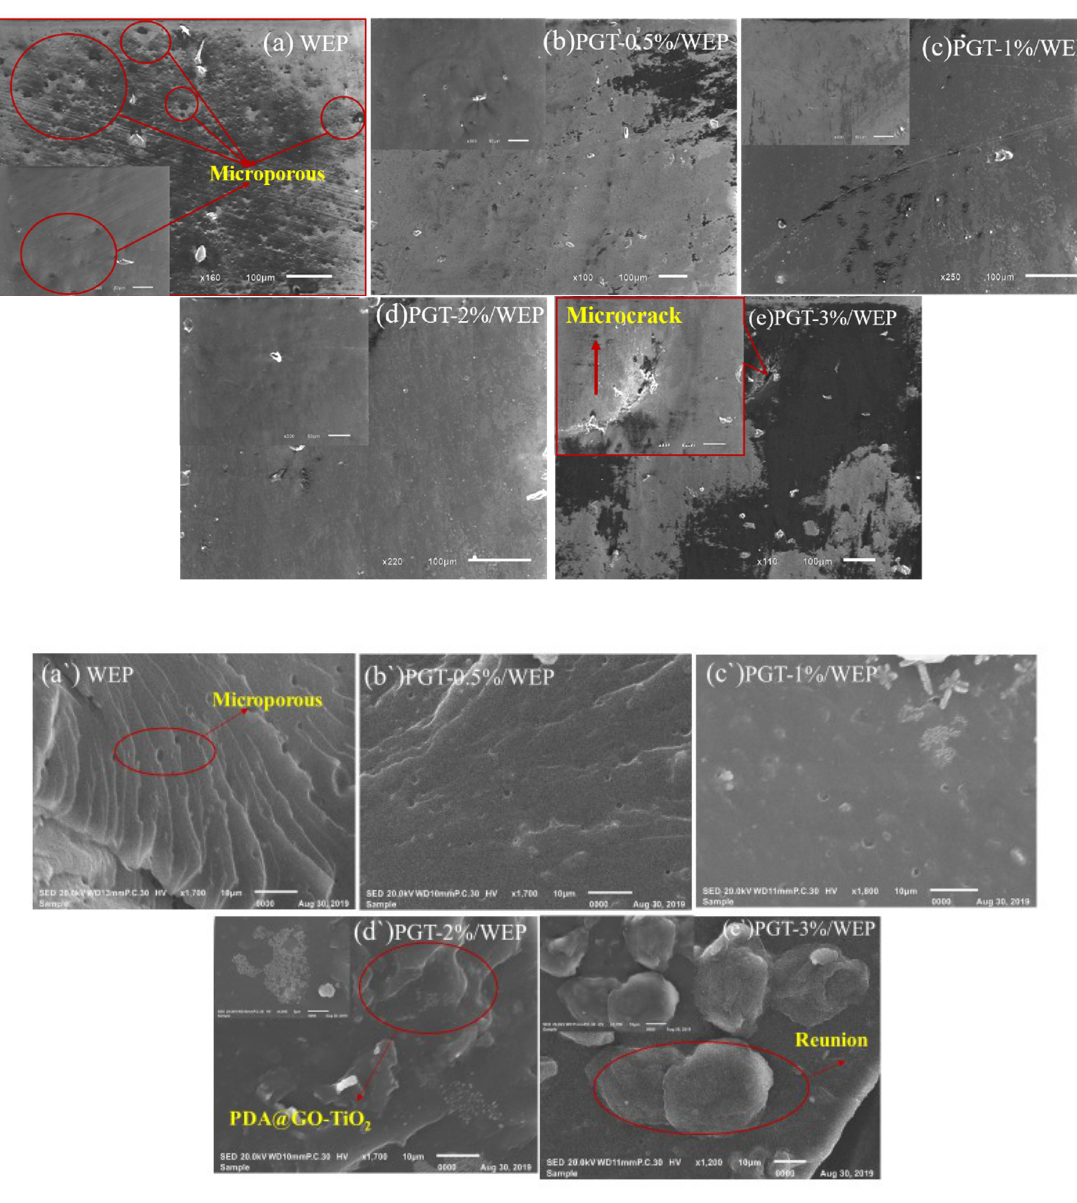
Figure 8. Scanning electron microscopy (SEM) surface image of ( a ) waterborne epoxy resin coating (WEP), ( b ) (PGT)-0.5% / WEP, ( c ) PGT-1% / WEP, ( d ) PGT-2% / WEP and ( e ) PGT-3% / WEP coating. SEM cross-sectional image of ( a‘ ) WEP, ( b‘ ) PGT-0.5% / WEP, ( c‘ ) PGT-1% / WEP, ( d‘ ) PGT-2% / WEP and ( e‘ ) PGT-3% / WEP coating.